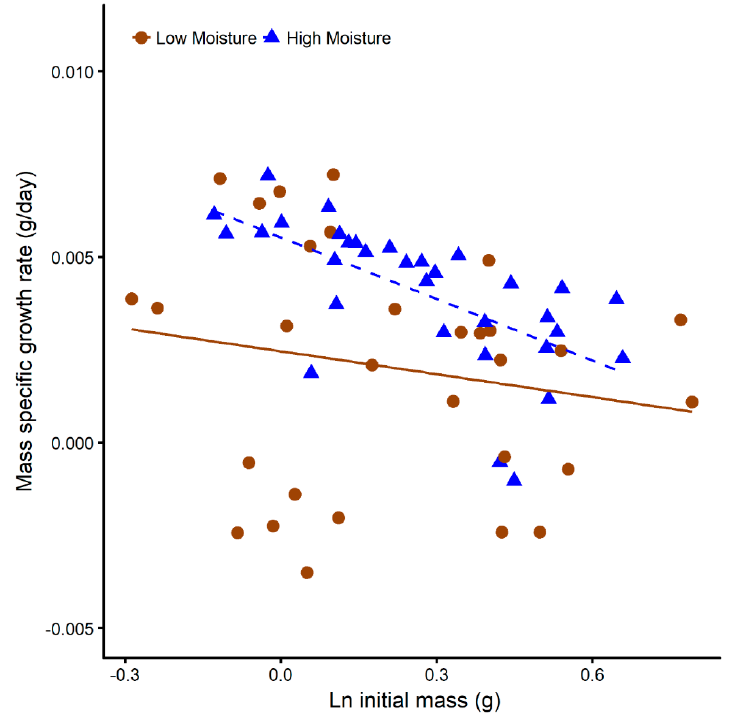
Figure 4. Mean mass-specific growth rate as a function of ln of mass at metamorphosis in low moisture (–– solid, brown line •) and high moisture (---- dashed, blue line ▲ ) treatments.